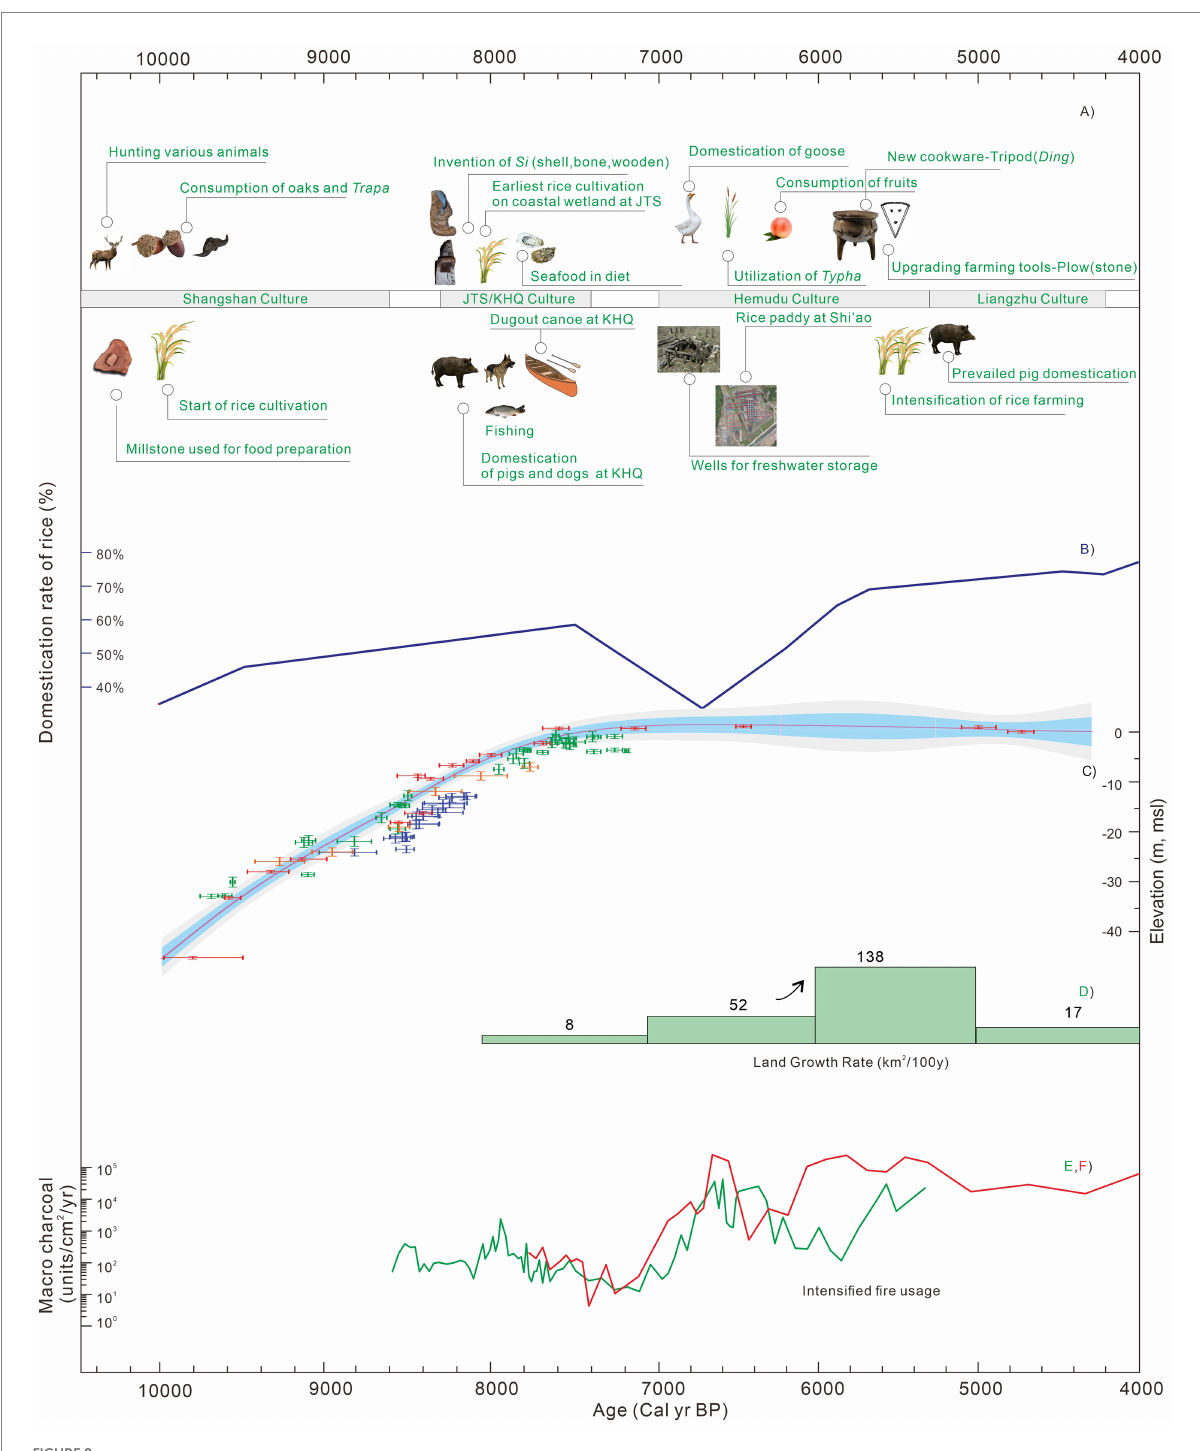
FIGURE 8 (A) Synthesis of the transformation process of subsistence strategies and landscape changes in the SHB. At each cultural stage, the most representative features of subsistence strategy were marked in the figure (data collected from Zong et al., 2007; Archaeological Research Center of Peking University and Zhejiang Provincial Institute of Cultural Relics and Archaeology, 2011; Jiang, 2014; Zhejiang Provincial Institute of Cultural Relics and Archaeology, 2016, 2021; Zuo et al., 2017; Zhang et al., 2020; Eda et al., 2022; Official account of Qianjiang Evening News, 2022). (B) Trends of the proportions of domesticated-type bulliform phytoliths from rice (Ma et al., 2016). (C) Holocene sea-level changes in the Hangzhou Bay (Xiong et al., 2020). (D) Land growth rate of SHB since coastal progradation at ~8,000 cal yr. BP (Liu et al., 2021). (E) Macro- charcoal influx of YJ1503 at JTS site (Liu et al., 2020). (F) Macro-charcoal influx of TJA